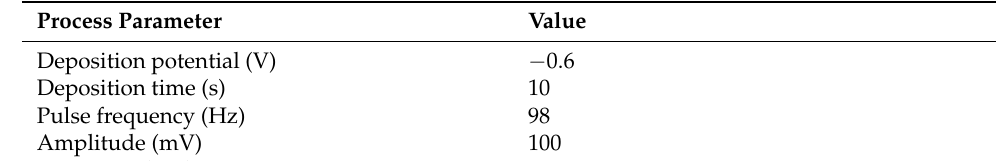
Table 2. Square wave ASV parameters.